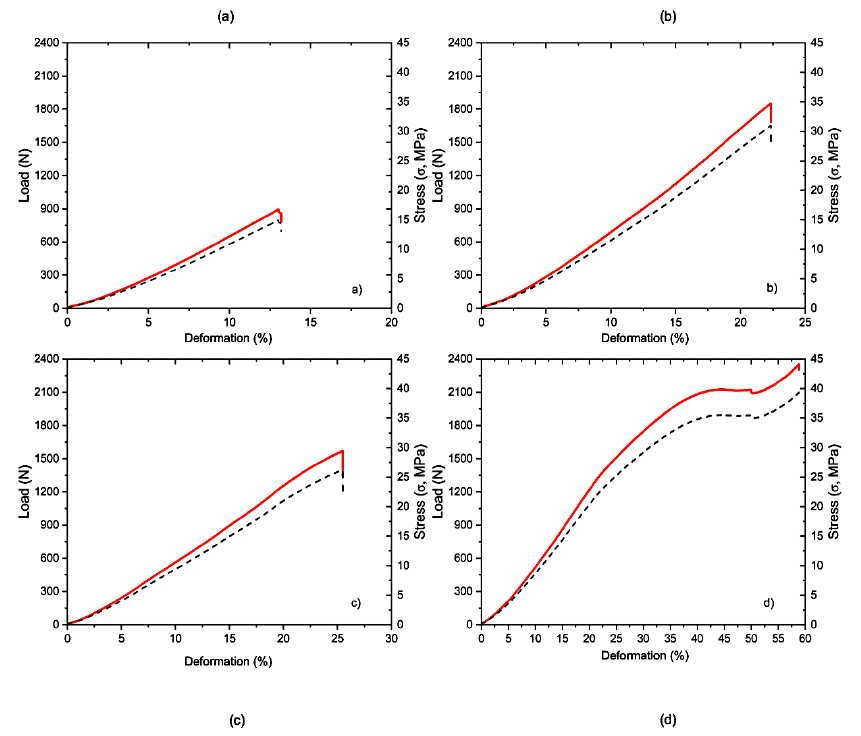
Figure 6. Force-displacement curves of the different materials analyzed: ( a ) PMMA; ( b ) GRA; ( c ) RA; ( d ) PS.